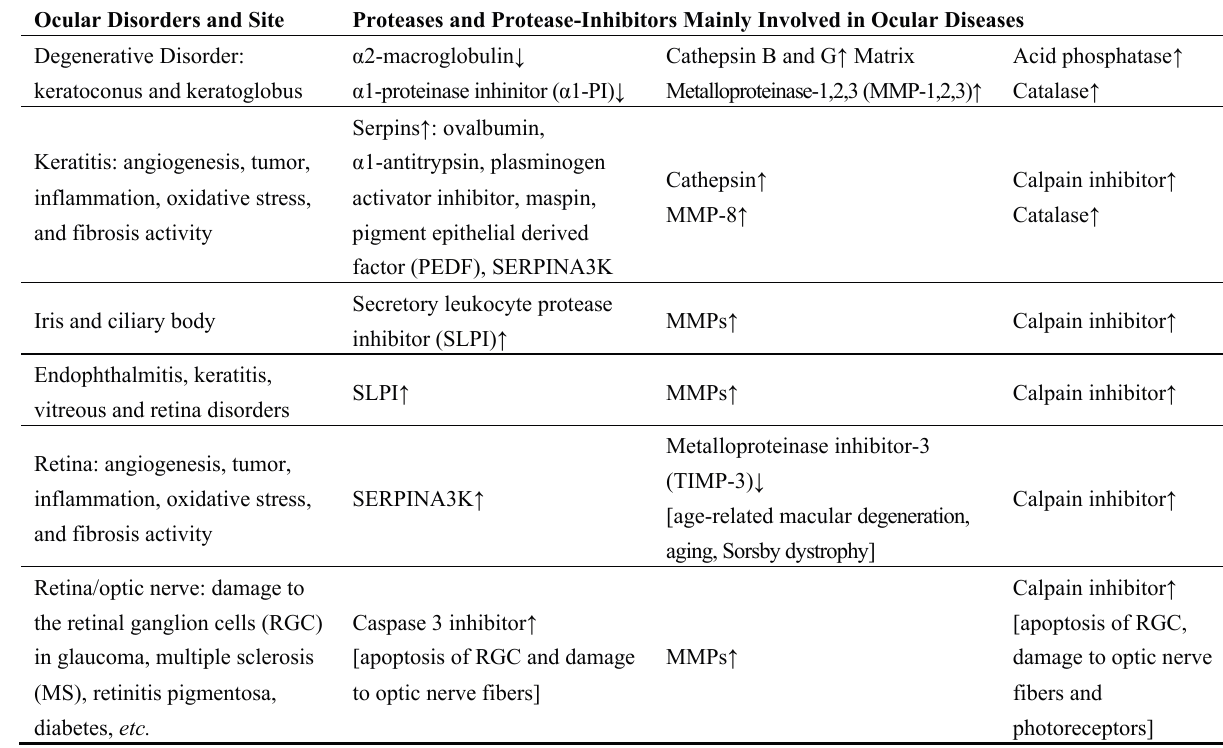
Table 1. Molecules most commonly involved in maintaining cellular and tissue